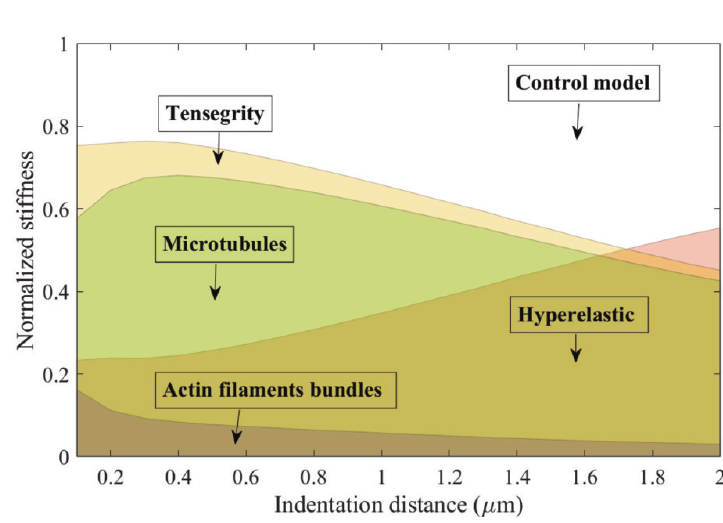
Figure 13. The average normalized stiffness attributed to different components in the integrated